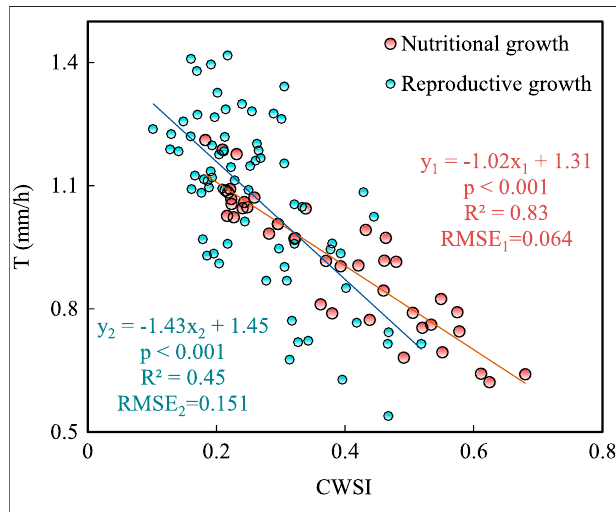
FIGURE 8 | Correlation between the T and CWSI of alfalfa in the nutritional growth stage and reproductive growth stage. All the p values represent the signi fi cance levels of the overall regression based on a Pearson test.